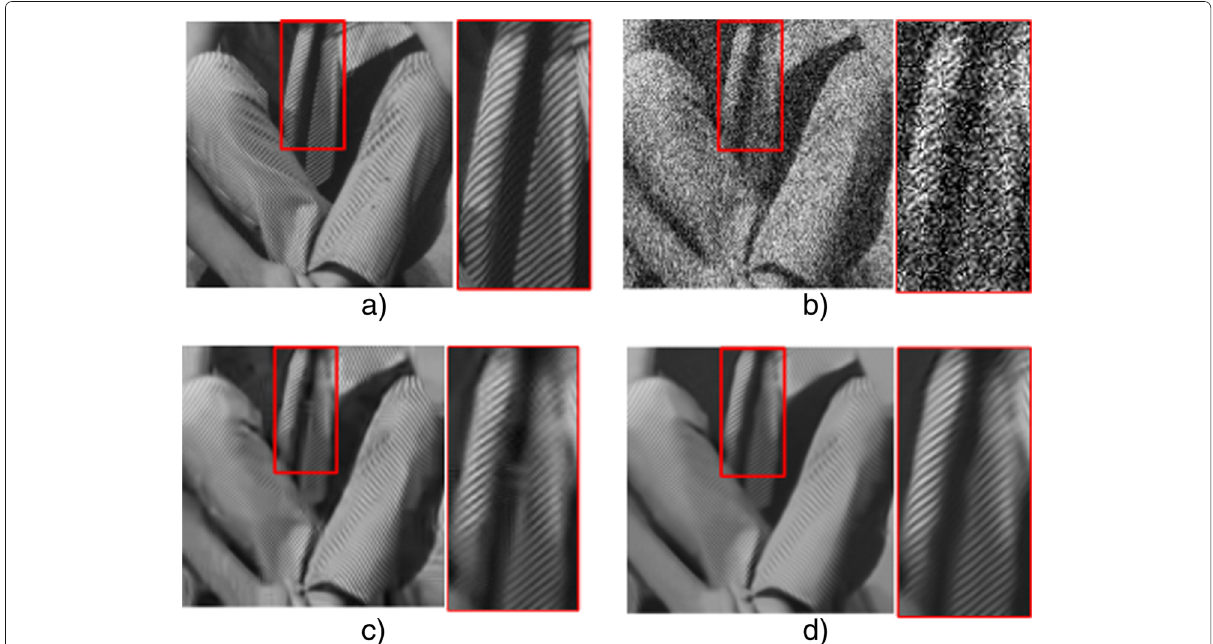
Fig. 7 Denoising for spatial complicated image scene comparing BM3D method with 3SD-based method. a Original: Barbara (a fragment) 256 ∗ 256. b Noisy: σ = 70; PSNR = 11.22; SSIM = 0.142. c BM3D denoising: PSNR = 24.08; SSIM = 0.7026. d 3SD denoising: PSNR = 24.21; SSIM = 0.765